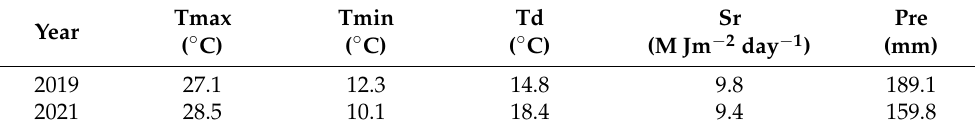
Table 2. Maximum temperature (T max ), minimum temperature (T min ), diurnal temperature variation (T d ), daily solar radiation (Sr), and accumulated precipitation (Pre) during the maize growing seasons in 2019 and